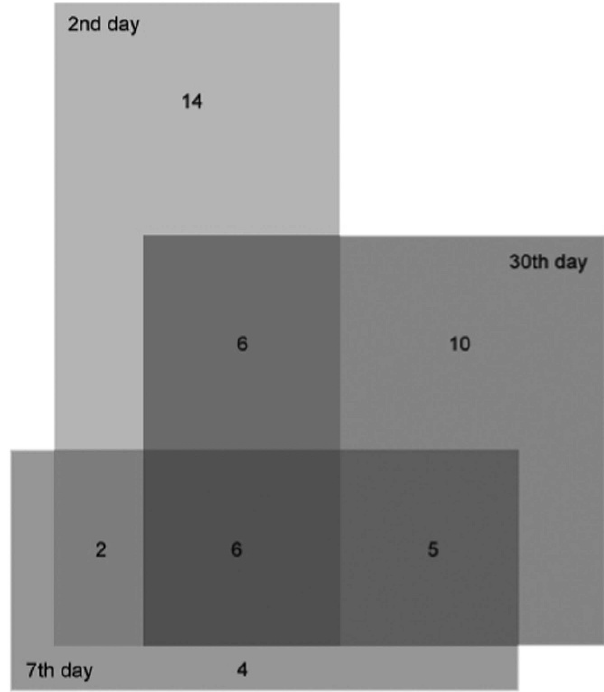
Figure 4 - Venn diagram showing the number of unique and shared OTUs among the neonates. A genus-based OTU definition was used ( $ 95% similarity